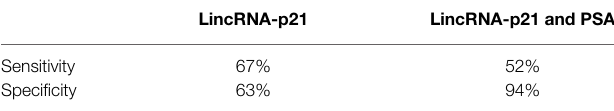
FIGURE 2 | The ROC curve for the LincRNA-p21 and PSA combination. TABLE 4 | Sensitivity and specificity of exosomal lncRNA-p21 and of the lincRNA-p21/PSA